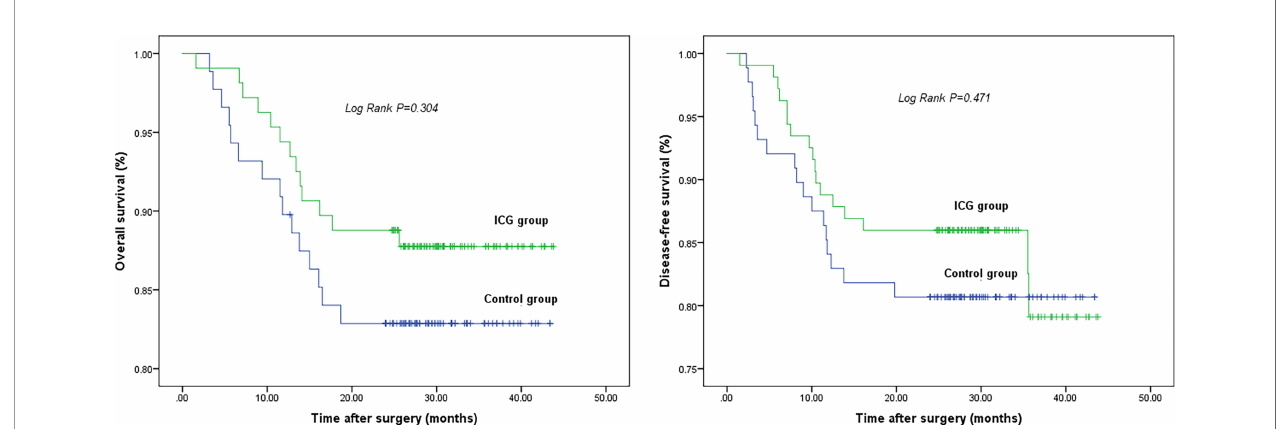
FIGURE 3 | 2-year overall survival (left) and 2-year disease-free survival (right). There is no difference in 2-year OS and 2-year DFS between